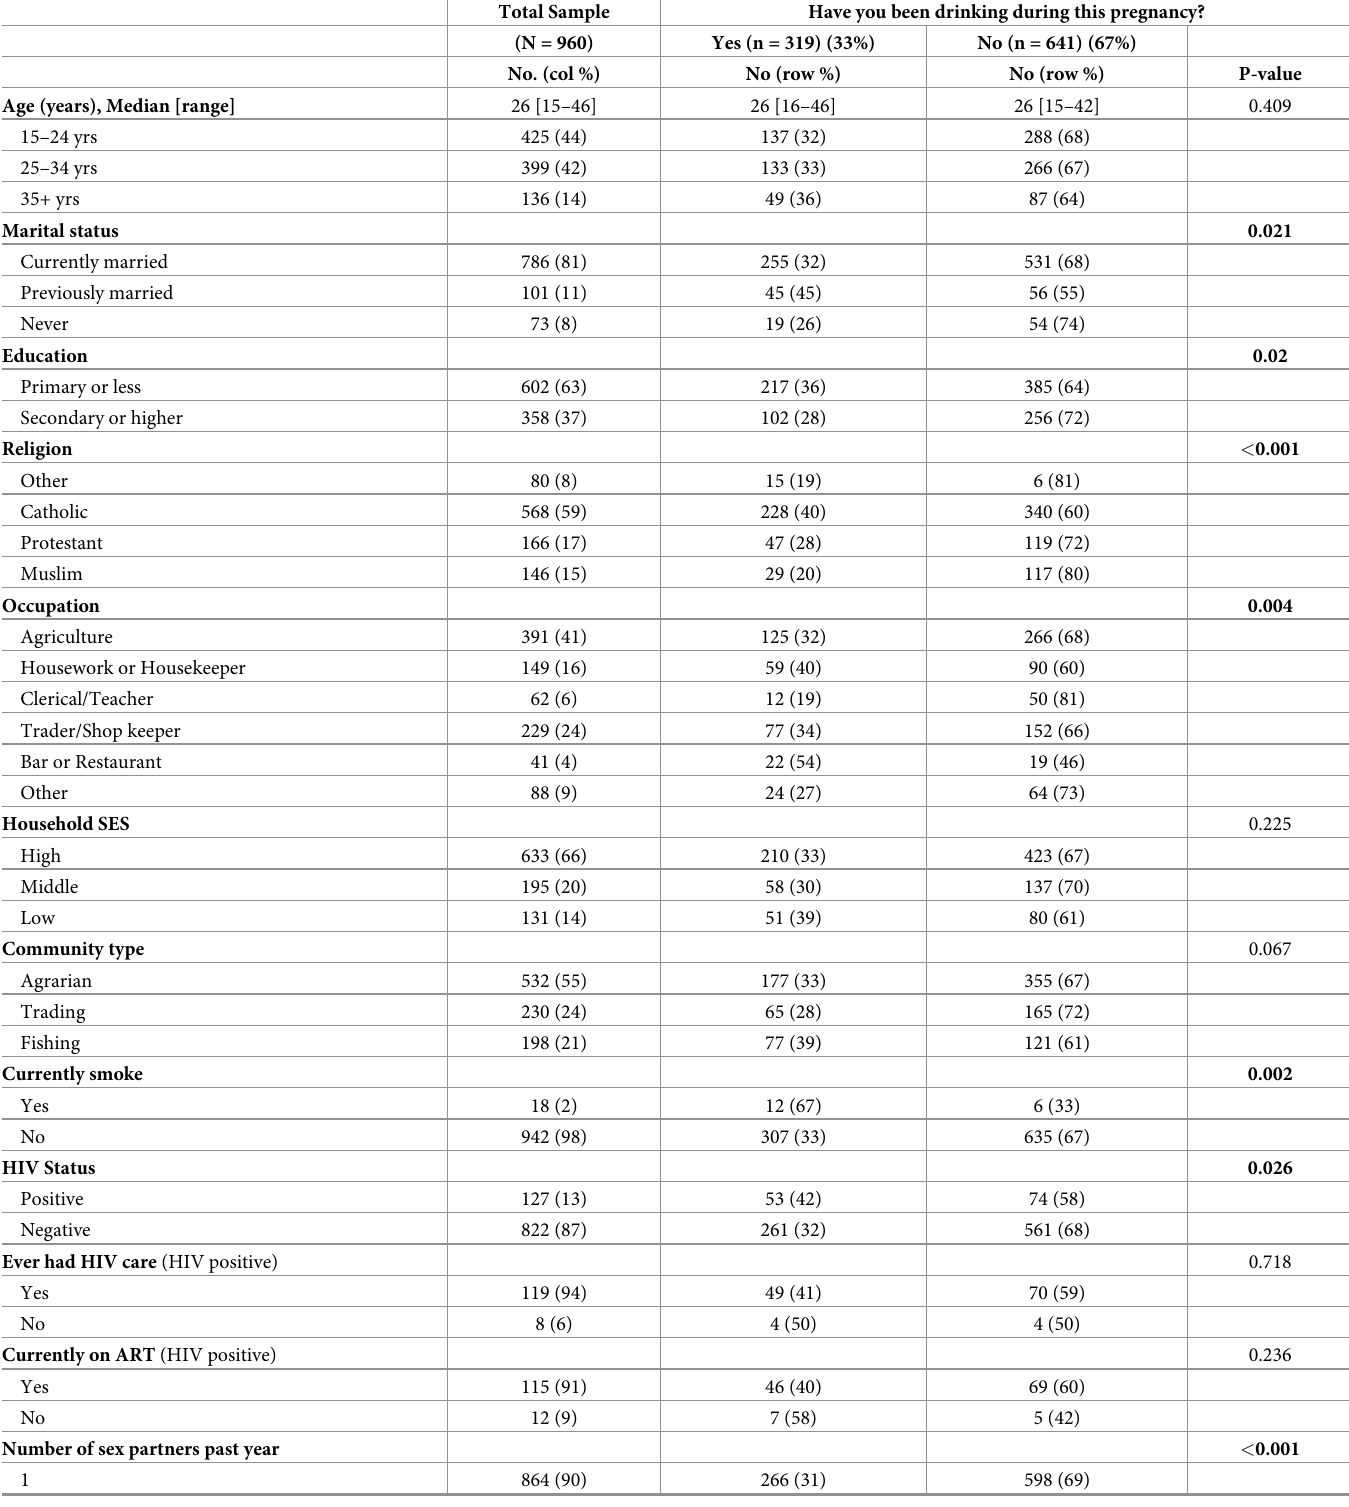
Table 1. Characteristics by alcohol use during pregnancy among participants in RCCS between March 2017 and September